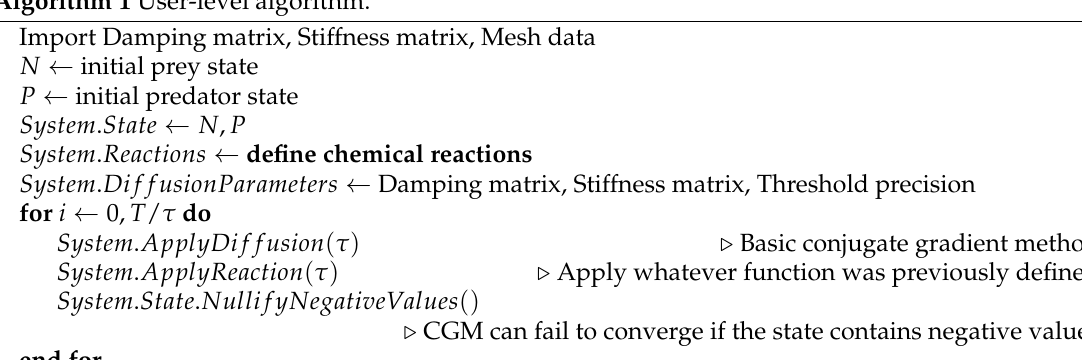
Algorithm 1 User-level algorithm.